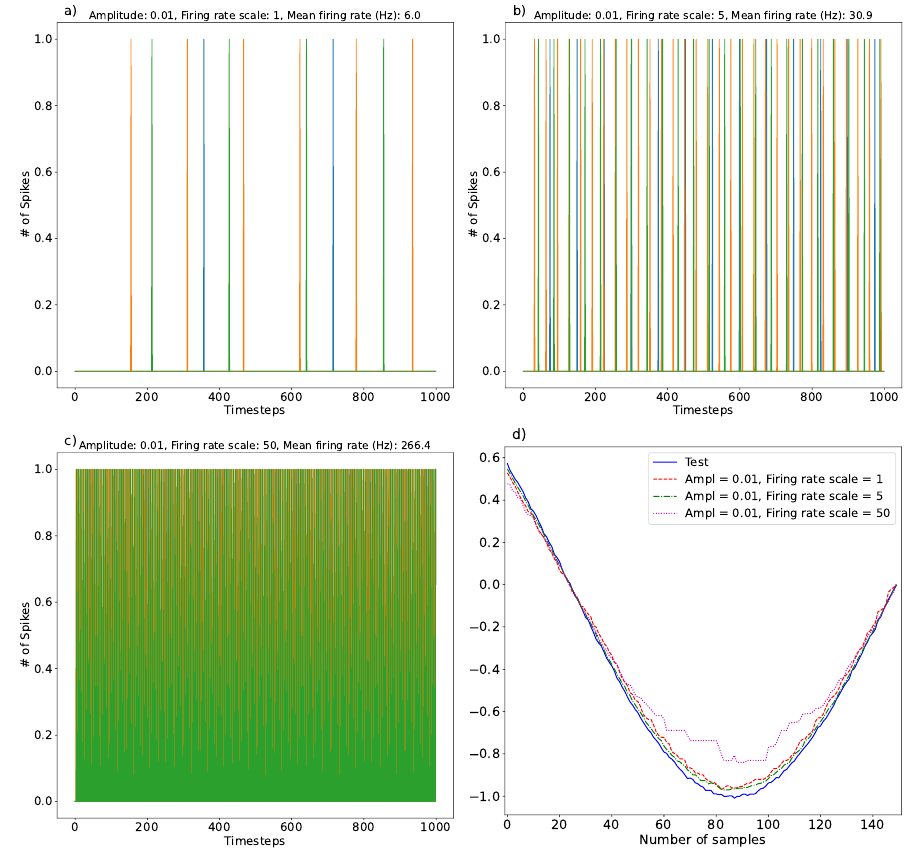
Figure 4. ( a ) Neural activities setting an amplitude = 0.01 and a firing rate scale = 1, ( b ) Neural activities setting an amplitude = 0.01 and a firing rate scale = 5, ( c ) Neural activities setting an amplitude = 0.01 and a firing rate scale = 50, and ( d ) predictions over the testing